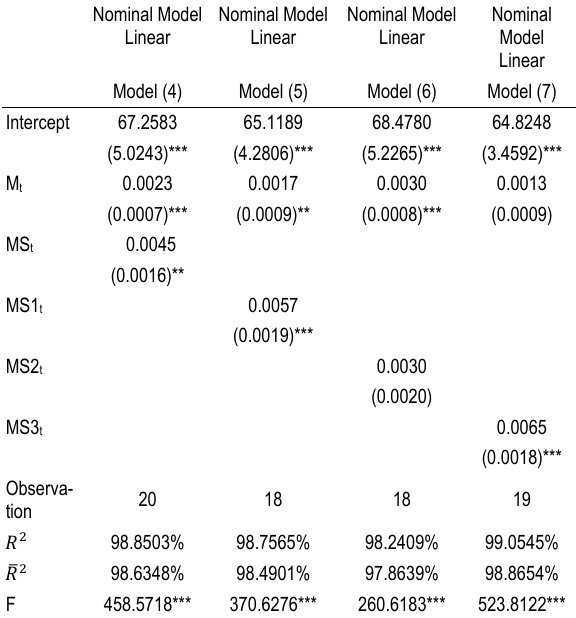
Table 2. The effect of money supply on price level (Price=100 in 2006). Price as the dependent